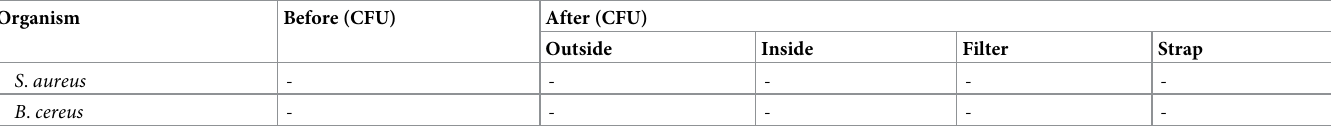
the elongation at break.